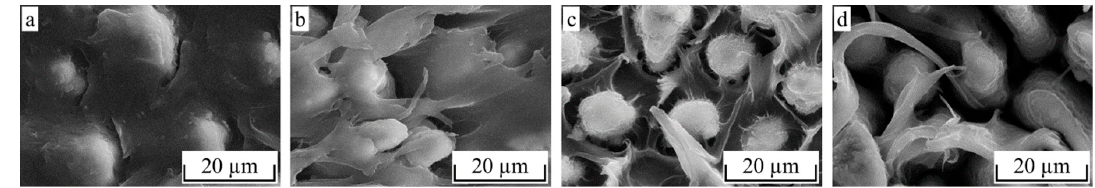
Figure 16. SEM images of the fractured surface of the pin-structured hollow cylinder specimens ( a, b ) shear load and ( c , d ) tensile load.